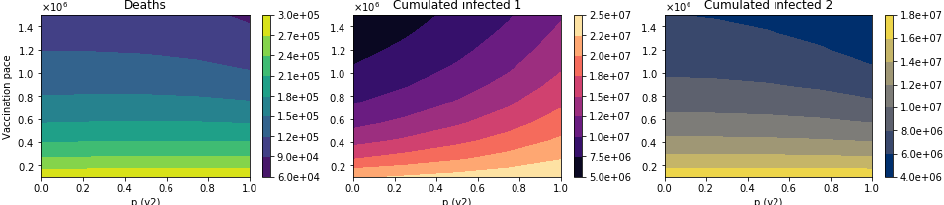
Figure 8. Total number of deaths and the cumulative number of infected people for each age group. This scenario considers a relatively high SARS-CoV-2 transmission rate and vaccine efficacy of 90%. The factors that are varied are the vaccination pace and the proportion of vaccines allocated to each age group.